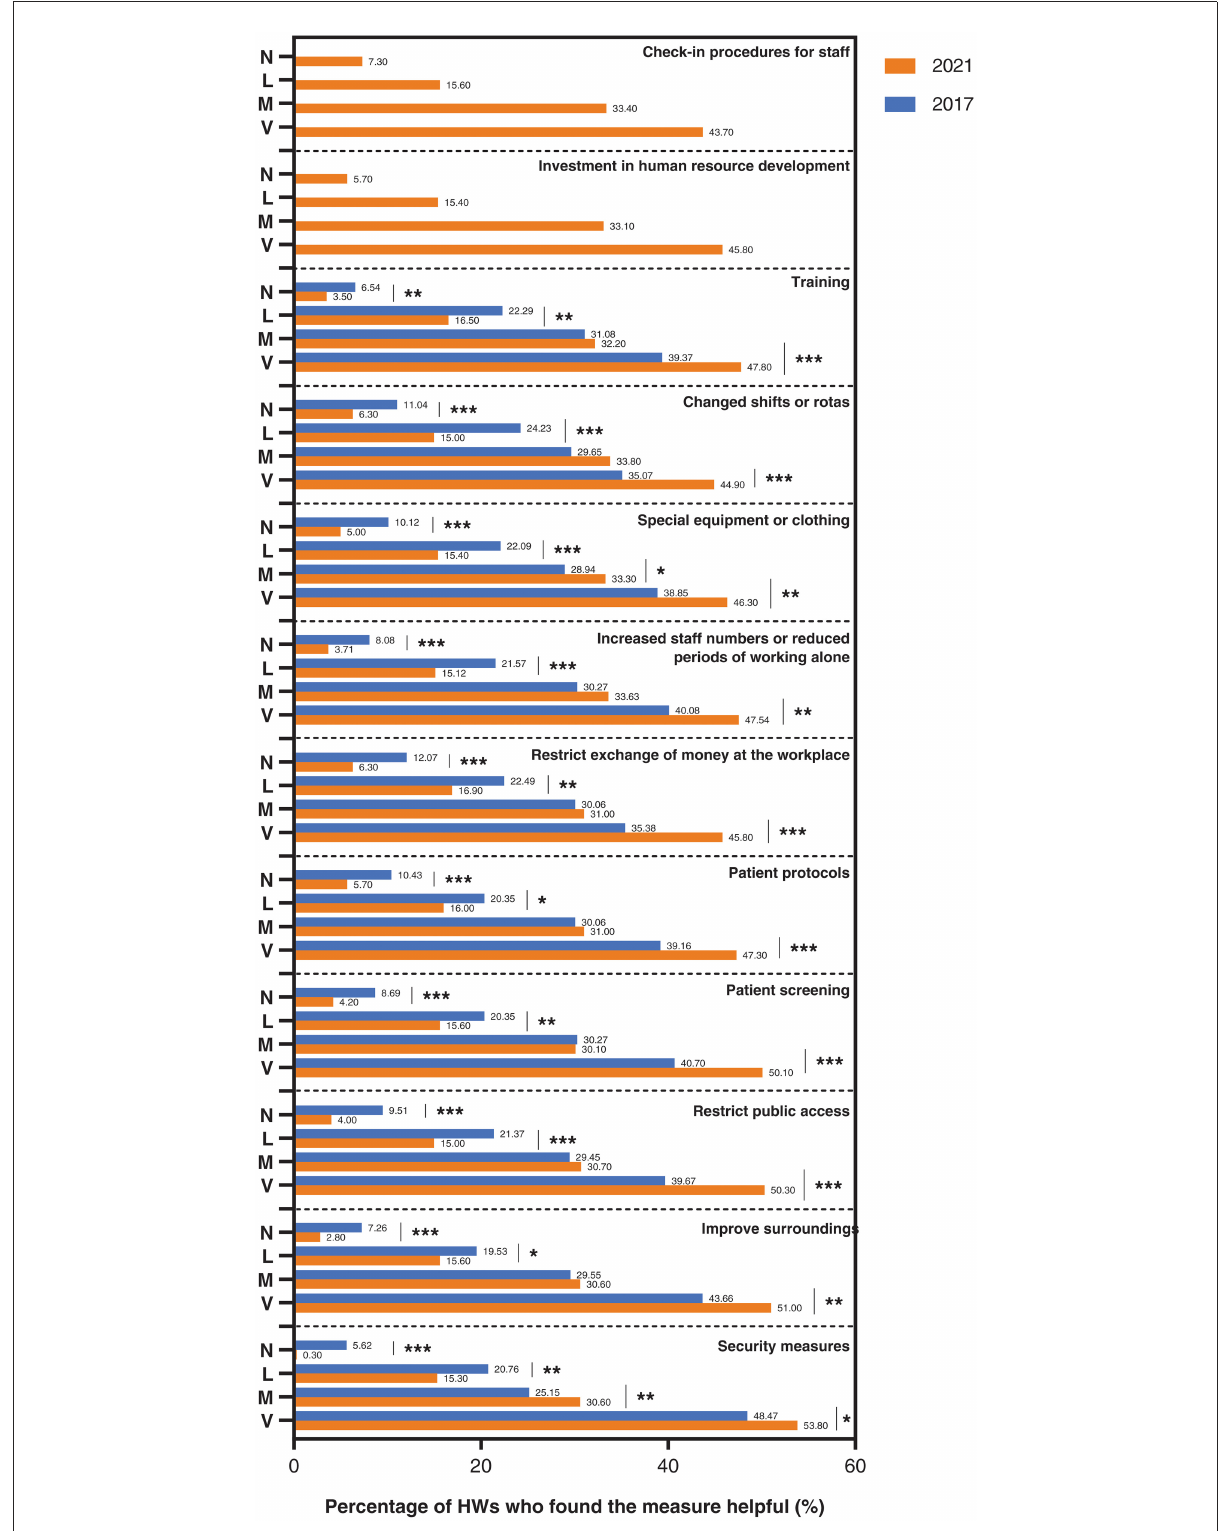
FIGURE4 The extent to which healthcare workers find various types of measures useful in their existing work. Both 2017 and 2021 in the figure refer to the year. V, M, L, and N stand for very, moderate, little, and not at all, indicating very helpful, moderate, slightly helpful, and not helpful, respectively. ***indicates that P < 0.001. **indicates that P < 0.01. *indicates that P < 0.05. Security measures(not at all): Pearson’s Chi square = 44.531,